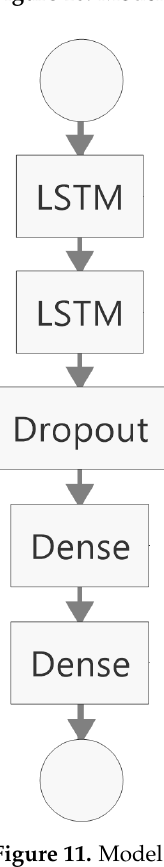
Figure 11. Model with two